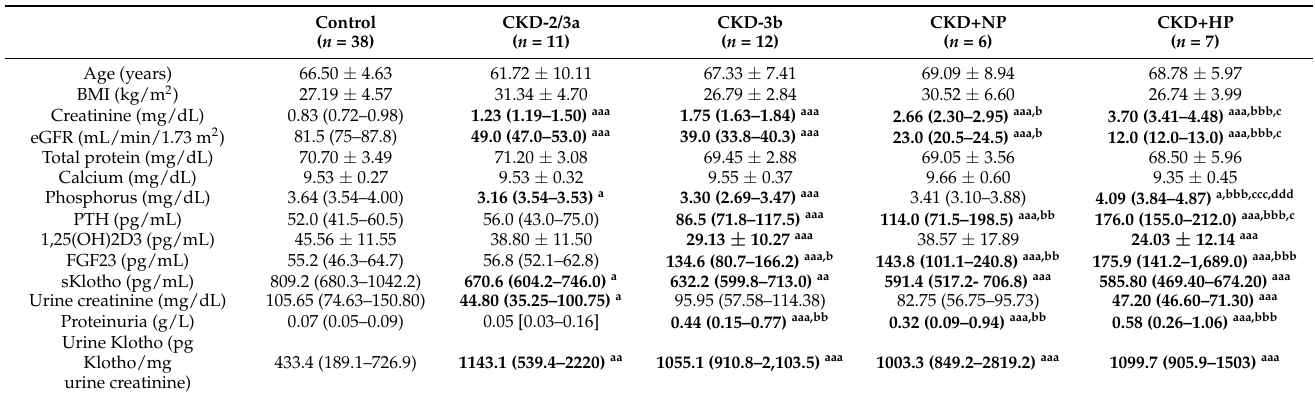
Table 2. Clinical and biochemical parameters and sKlotho in the CKD patients.